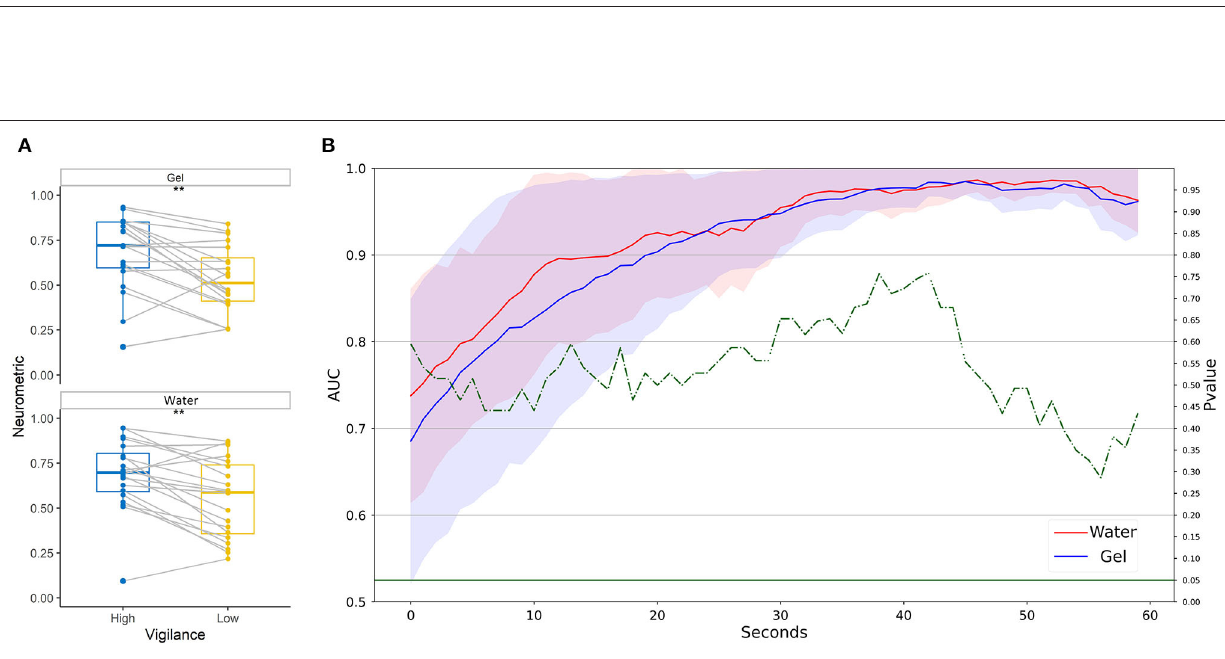
FIGURE 8 | Vigilance discrimination between low and high conditions in laboratory settings. (A) Statistical comparison has been performed for water-based and gel-based Neurometrics. The asterisks show the results of the Wilcoxon signed-rank test (** p < 0.01). (B) AUC values obtained by water (in red) and gel (in blue) electrodes for different time resolutions (1–60s). The solid lines represent the median of the AUC among the participants. The shadows represent the mean absolute deviation of the AUC across participants. The dashed green line represents the results in terms of p -values of the Wilcoxon signed-rank test. The threshold of significance ( p = 0.05) has been highlighted in the same